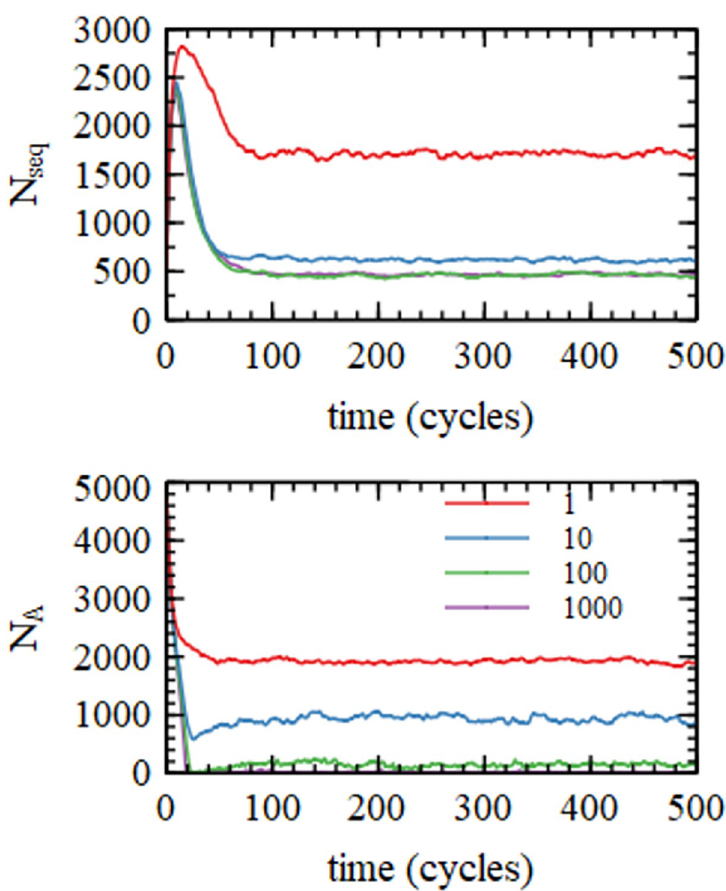
Fig 3. Number of sequences, N , and number of free A nucleotides, NA, as a function of time in cycles for four seq simulations with varying values of the monomer addition rate k add